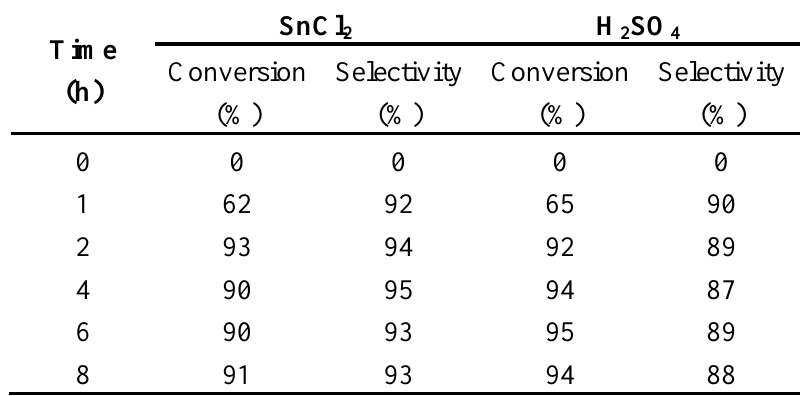
Table 1. Conversion and selectivity of ethanolysis of oleic acid catalyzed by SnCl and H SO 2 4